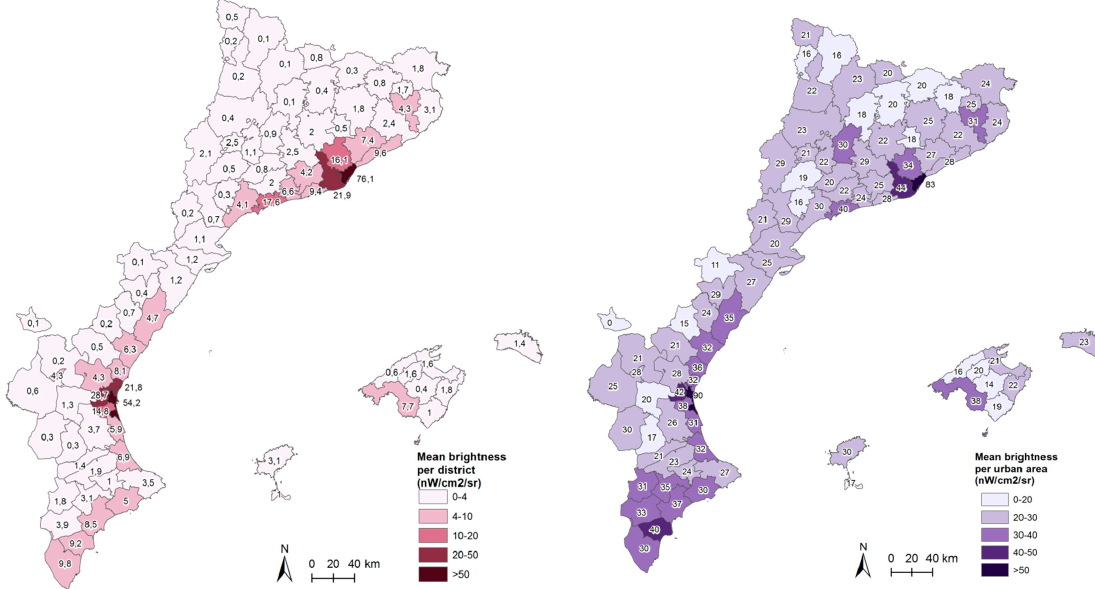
Figure 4 . Weighted mean brightness, mean for the months of October (2012–2017). Figure 6. Weighted mean brightness, mean for the months of October